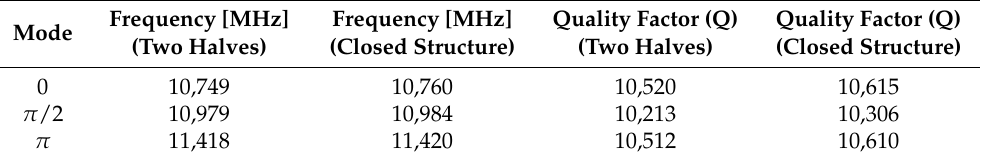
Table 1. Comparison between mode frequencies and quality factors for the closed structure and two-half